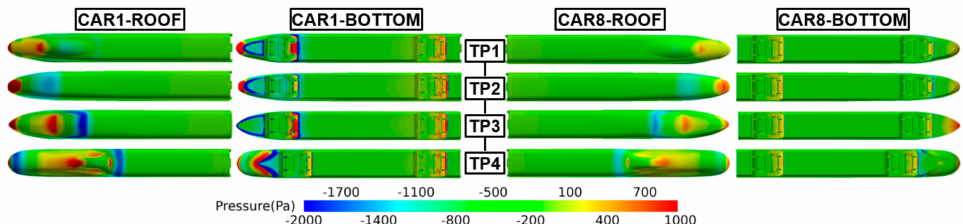
Figure 9. Contours of the time-averaged pressure on the head and the tail for different models.